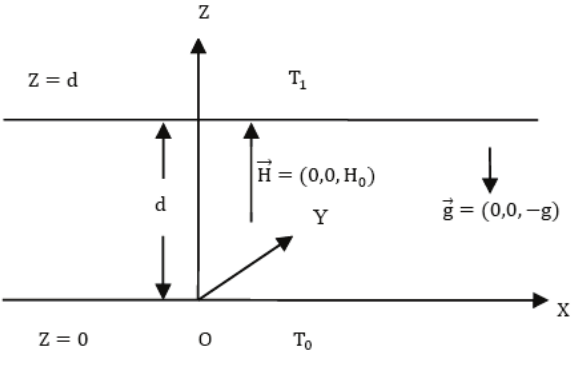
Fig. 1. Geometrical